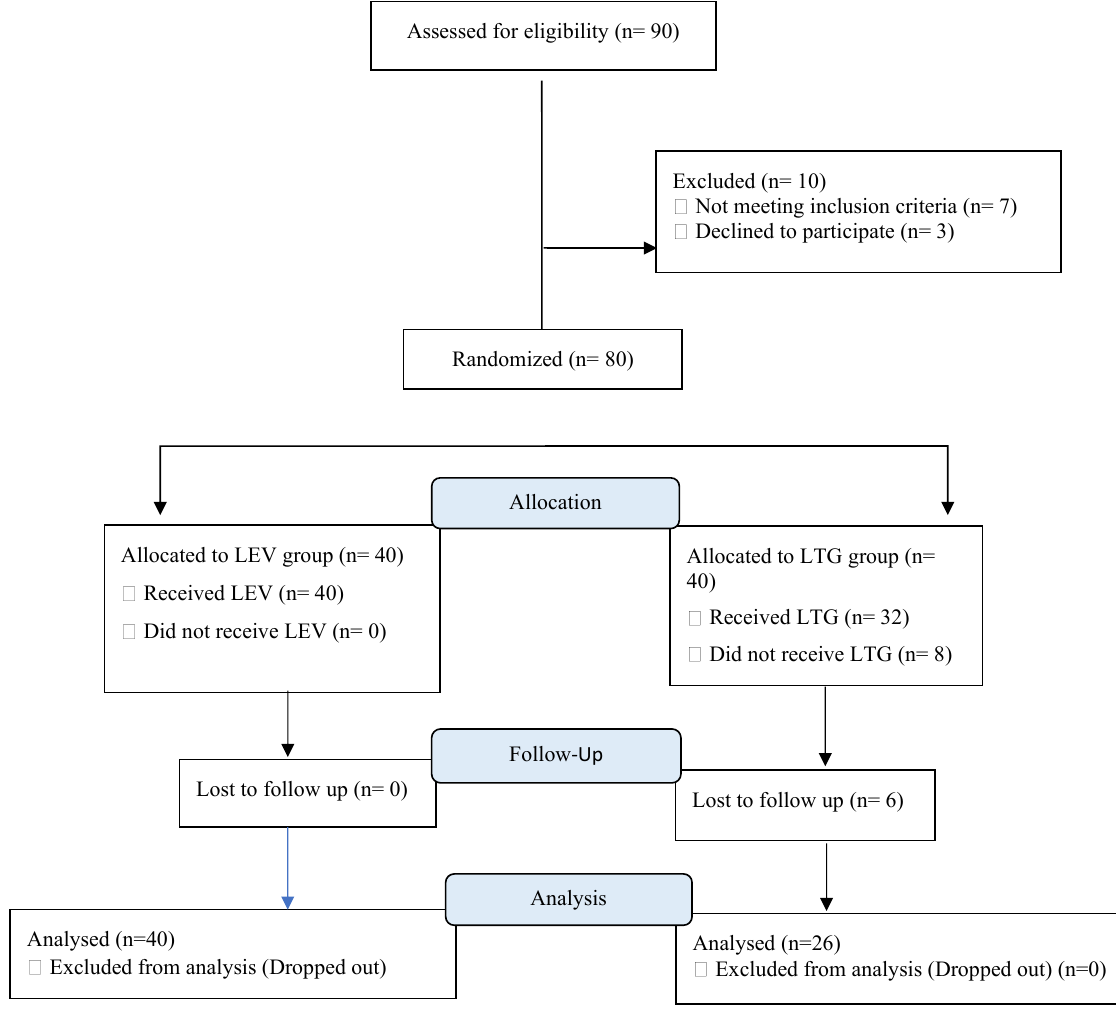
Figure 1. CONSORT Flowchart of the Study. Note . LEV: Levetiracetam; LTG: